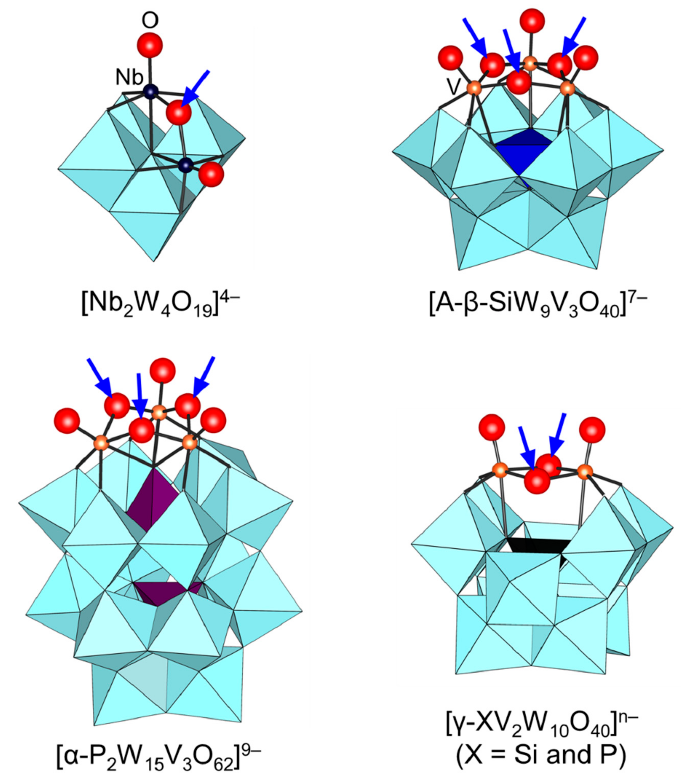
Figure 7. Molecular structures of vanadium- and niobium-containing POMs. The arrows indicate the possible protonation sites proposed on the basis of the structure, NMR, and computational analysis [72,75–77,95–101].